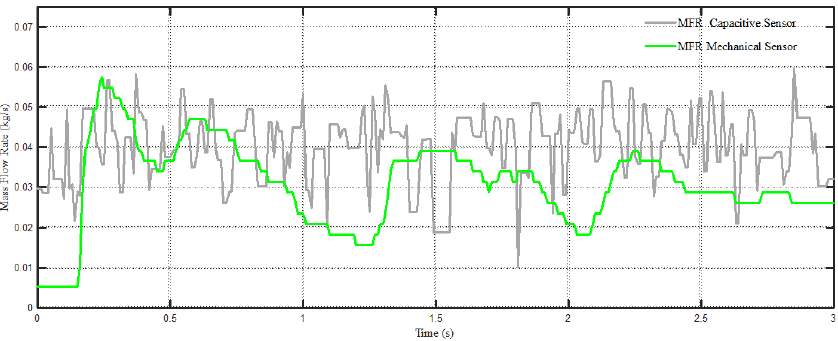
Figure 16. MFR of sand particles measured by electrical and mechanical sensors.